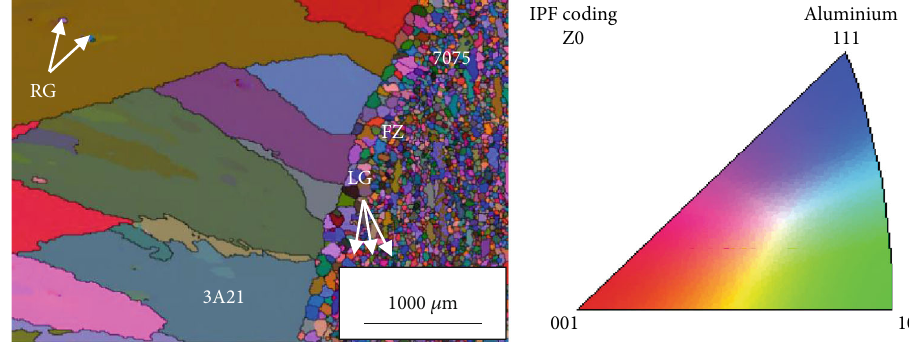
Figure 2: Evolution of grain morphology and size of the 3A21/7075 cladding material. Table 3: Fraction of three kinds of grains